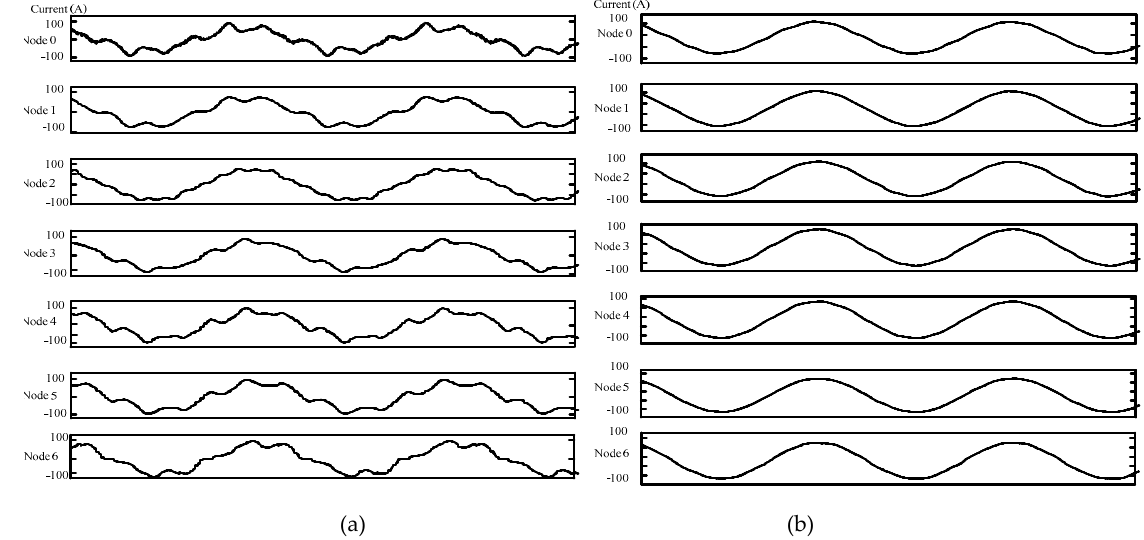
Figure 10. Current waveform with nonlinear load and background harmonic: ( a ) VI-APF off, and ( b ) VI-APF on.